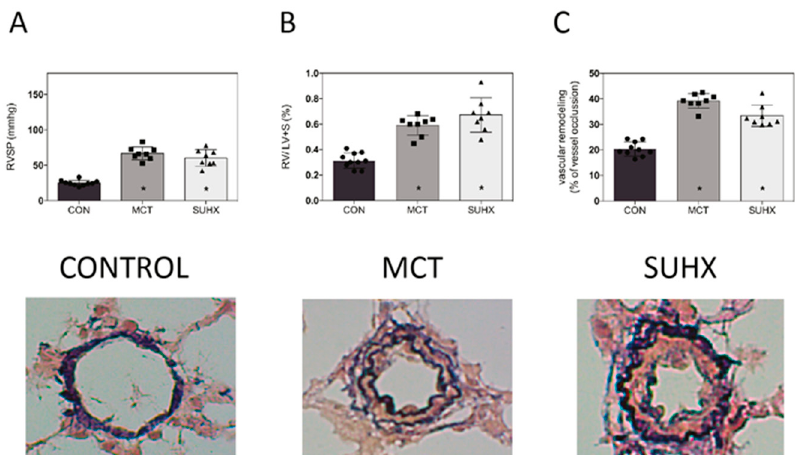
Figure 3. Characteristics of pulmonary arterial hypertension (PAH) animal models: Monocrotaline (MCT) and Sugen hypoxia (SuHx) with ( A ): RVSP = right ventricle systolic pressure, ( B ): Fulton index (RV / LV + S) and ( C ): vascular remodeling. Typical examples of vessel remodeling are shown below (Elastica van Gieson (EvG) staining, 400 × magnification). * = p < 0.05.